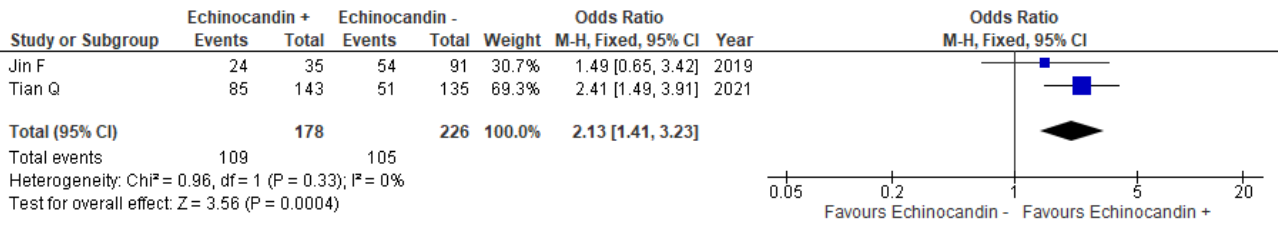
Figure 3. Forest plot of odds ratios for the comparisons of positive response rates between